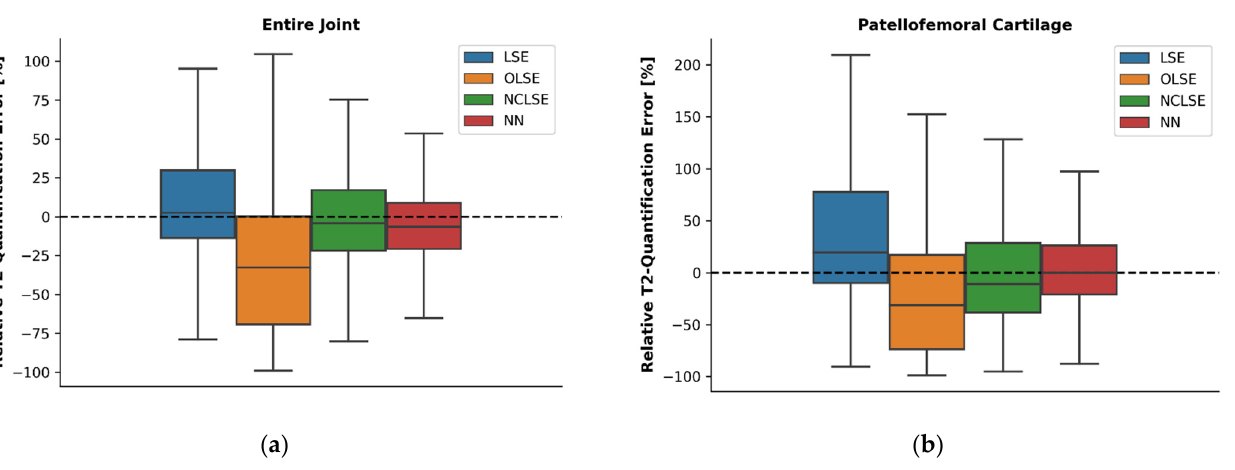
Figure 2. Relative T2 quantification errors (RQEs) [%] as a function of fitting method in the entire joint ( a ) and the patellofemoral cartilage ( b ) across all seven knee joint specimens in the “low-SNR” data, computed with respect to the reference T2 relaxation times. The reference T2 relaxation times were estimated using the LSE fitting method and the corresponding “high-SNR” image. For an explanation of the boxes, lines, and whiskers please refer to Figure 1.